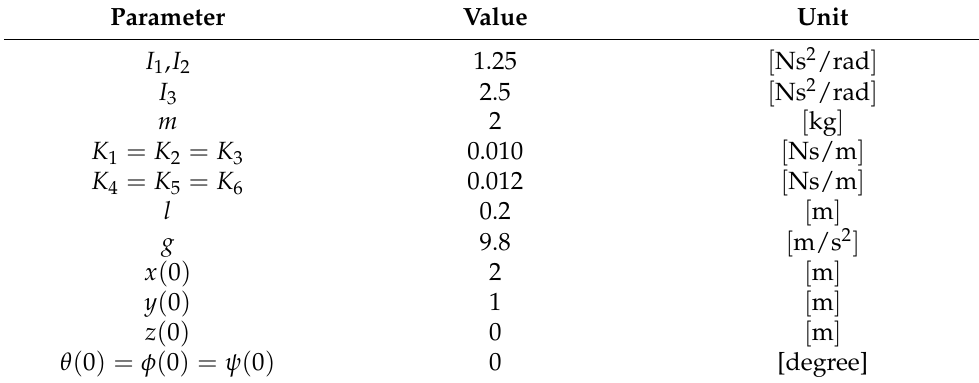
Table 1. Numerical parameters of the quadrotor model.